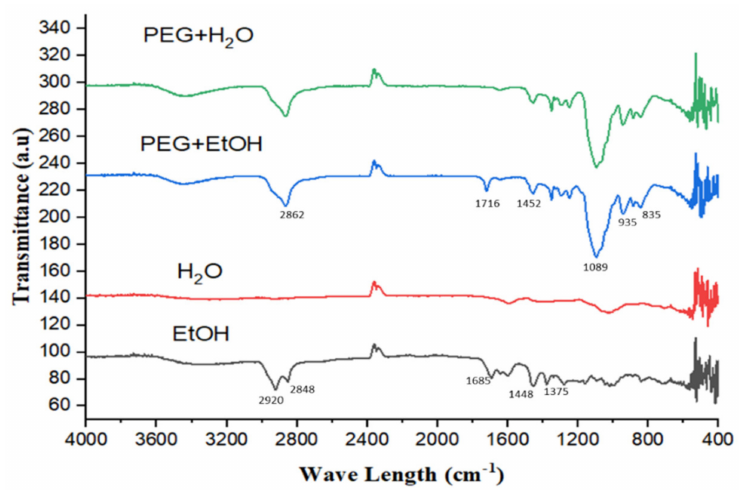
Figure 3. Spectra of FTIR for the propolis extracts prepared using ethanol, water, and PEG-400 in ethanol and PEG-400 in water at pH